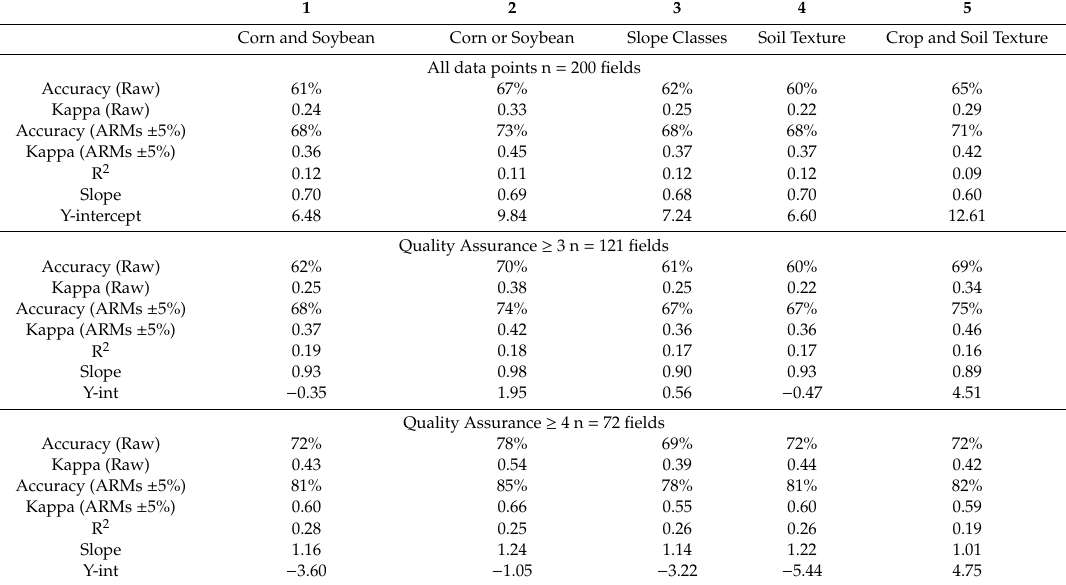
Table 3. Summary statistics for five methods of assessing crop residue cover for all ARMS fields (top), for fields with quality assurance flag > 3 Landsat images (middle), and for fields with quality assurance flag ≥ 4 Landsat images (bottom). Both raw ARMS data and ARMS ± 5% at the category boundary are